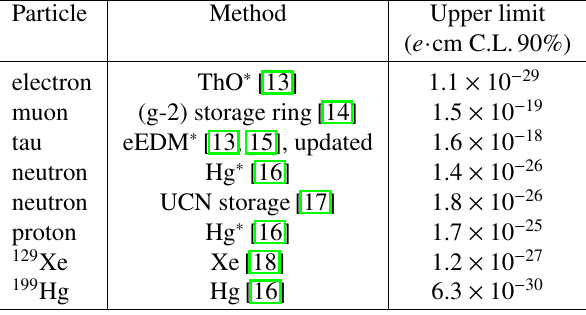
Table 1. List of most stringent limits on permanent EDMs. Results which are deduced under the “sole source” assumption (see text) are marked with an asterisk ( ∗